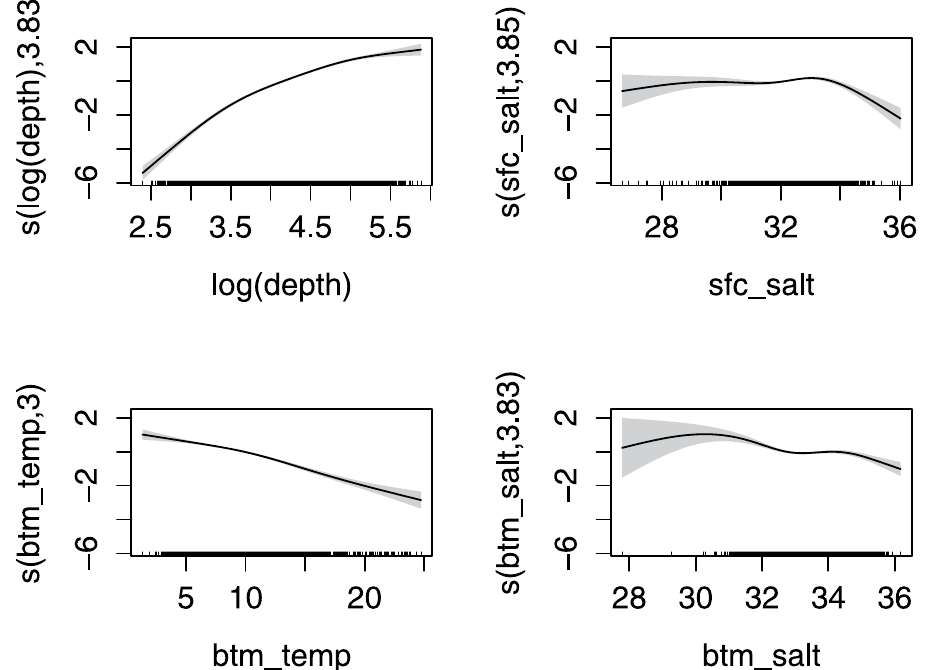
Figure 2. GAM response curves. Values indicate the relative impact of the variable on the projected population size, with shading indicating 2x standard error. Tick marks on the x-axis show individual observations. Numbers in the y-label indicate effective degrees of freedom for the variable.